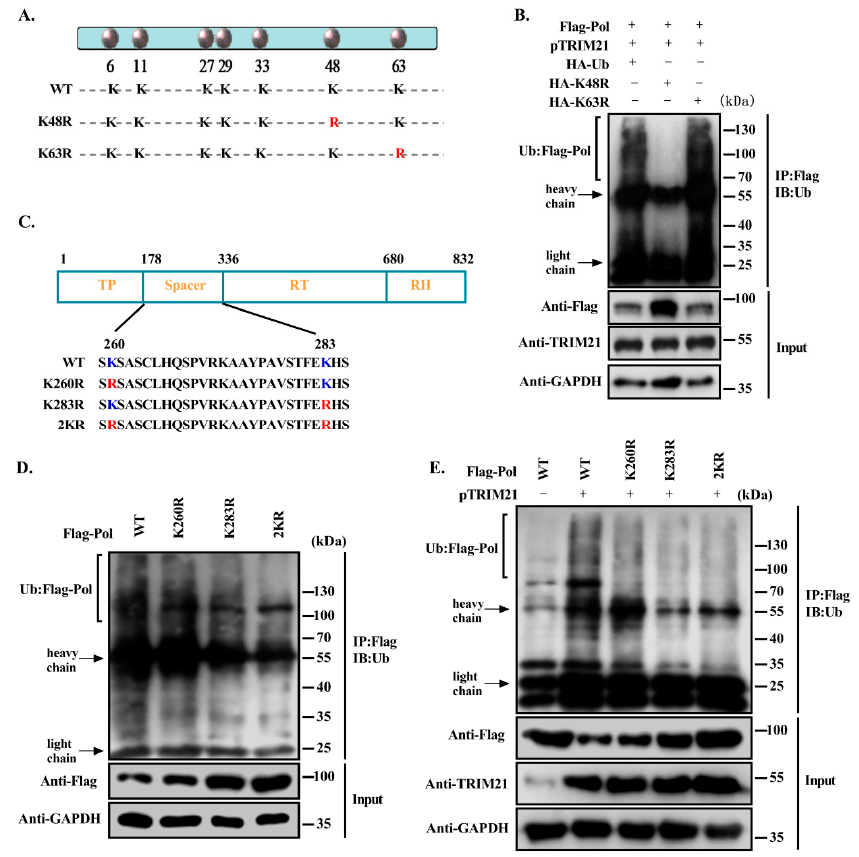
Figure 5. TRIM21 mediates the K48-linked ubiquitination of HBV DNA Pol at K260 and K283. ( A ) A schematic diagram of the lysine point mutations of ubiquitin. ( B ) Overexpression of HBV DNA Pol and TRIM21 in Huh7 cells cotransfected with HA-ubiquitin, Ub-K48R or Ub-K63R mutants. A ubiquitination assay and Western blot were used to detect the ubiquitination and protein level of HBV DNA Pol. ( C ) Schematic of the potential ubiquitination sites of HBV DNA Pol. ( D ) Huh7 cells were transfected with FLAG-HBV DNA Pol or its lysine point mutants, and ubiquitination assays were used to analyze the ubiquitination level of HBV DNA Pol and its lysine mutants. ( E ) TRIM21 and FLAG-HBV DNA Pol or its lysine mutants were cotransfected into Huh7 cells, and the effect of TRIM21 on the ubiquitination level of HBV DNA Pol and its lysine mutants was detected by ubiquitination assay. Data are representative of three independent experiments with three replicates each. 3.6. TRIM21 Restricts HBV DNA Replication, and the SPRY Domain is Crucial for the Antiviral Role of TRIM21